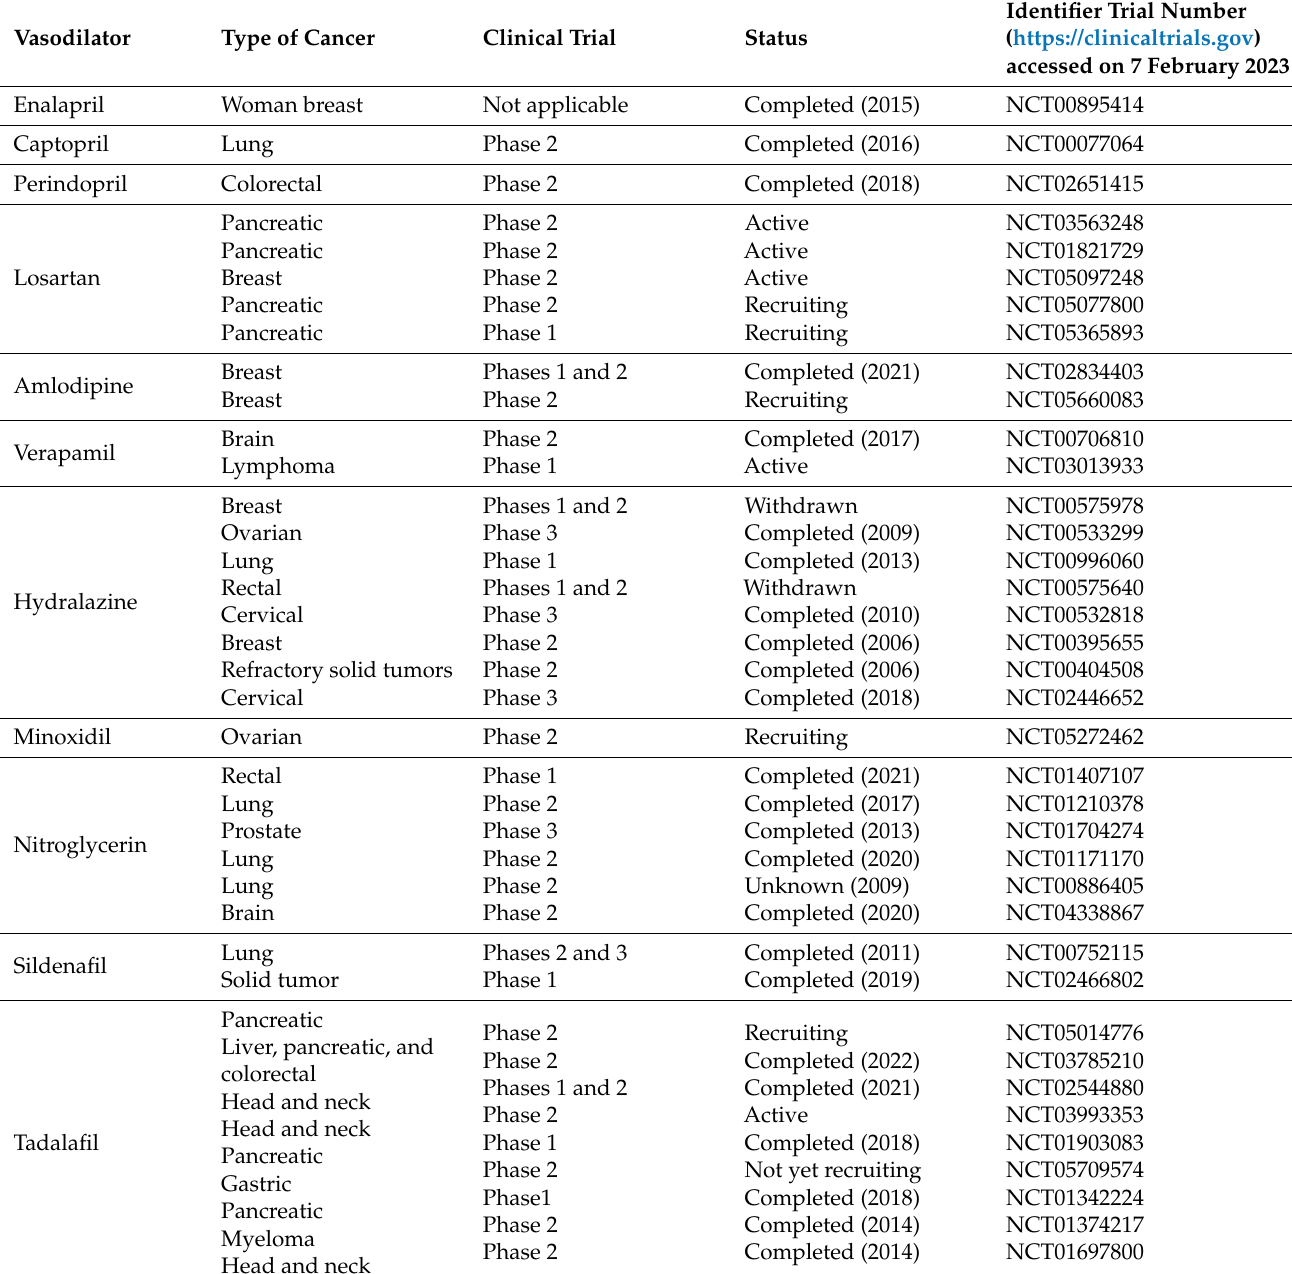
Table 2. Clinical trials involving vasodilators against types of